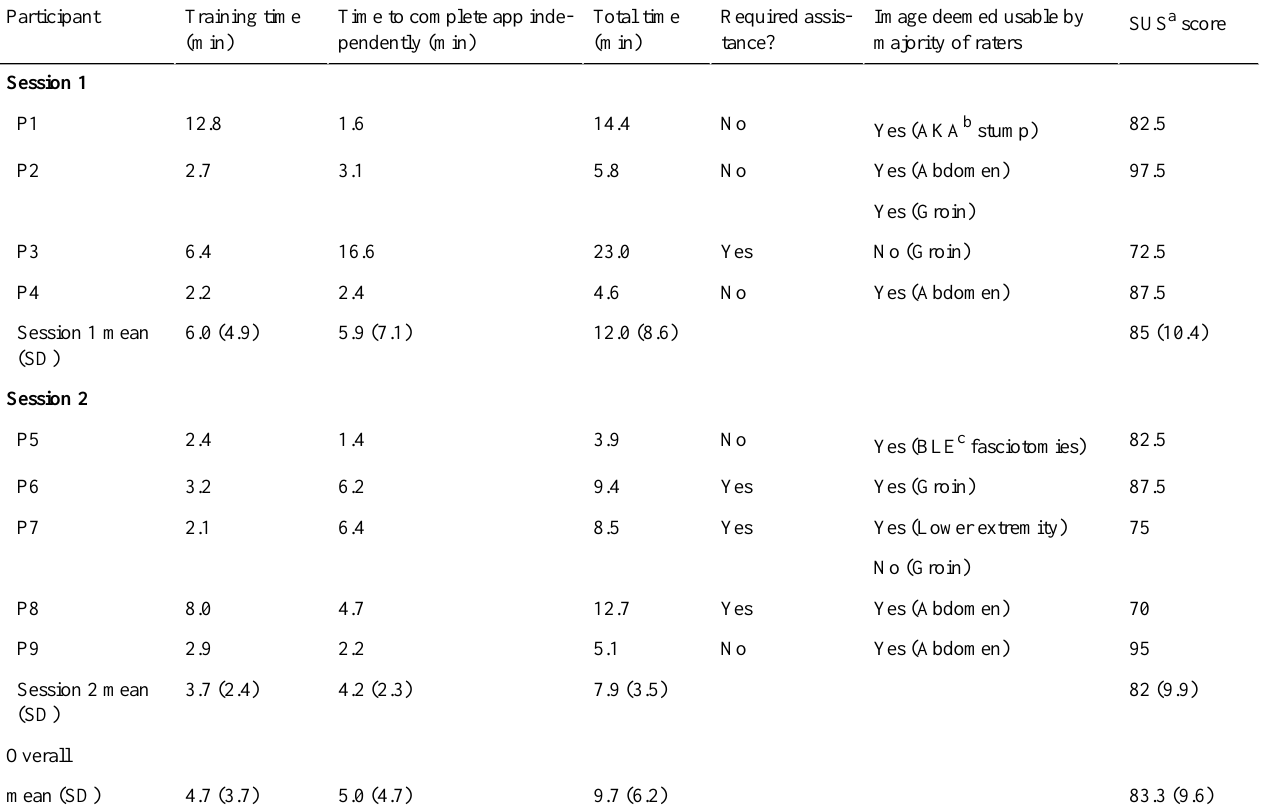
Table 4. Effectiveness, efficiency, and satisfaction results of usability